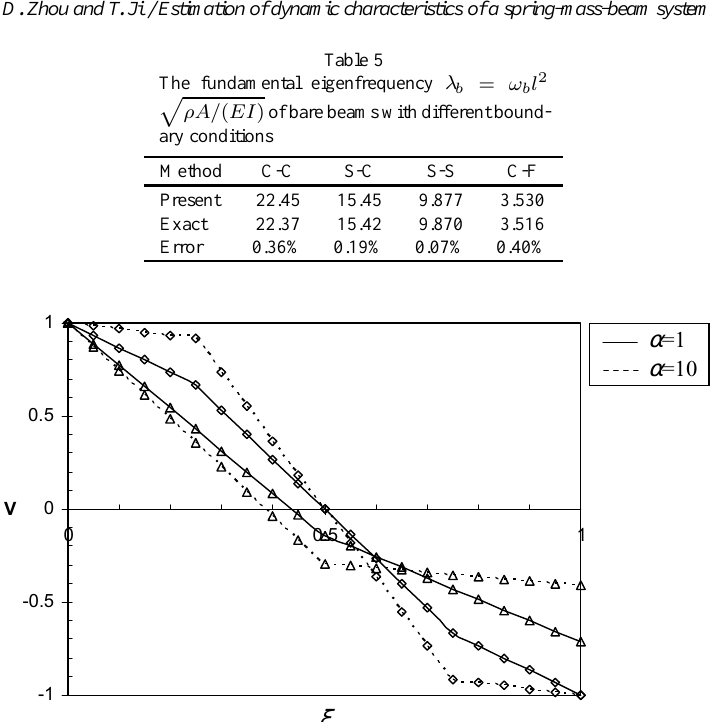
Fig. 5. The mode shear forces of a simply supported beam with a uniformly distributed spring-mass in respect to different positions and mass density ratios, ( ξ 1 = 0 . 0 , ξ 2 = 0 . 5 ), ( ξ 1 = 0 . 25 , ξ 2 = 0 . 75